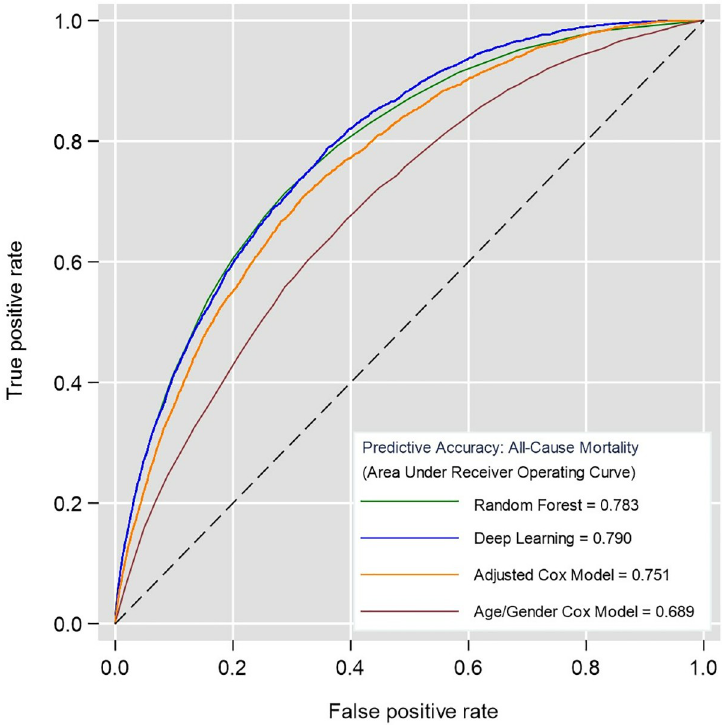
Fig 3. Receiver operating curves derived from predicting all-cause mortality in the test cohort (n = 125,657) using Cox models, random forest and deep learning. Higher area under the curve (c-statistic) shows better discrimination.